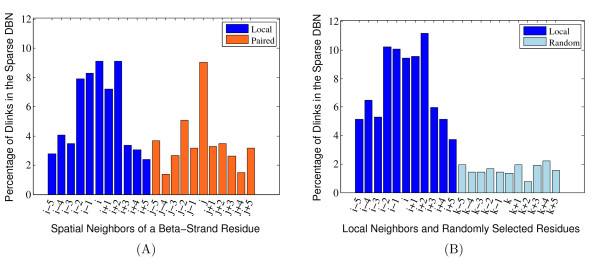
Comparison of the local and non-local correlations in β strands. (A) The figure plots the percentage of dlinks for the local and paired neighbors of a β strand residue at position i. (B) Similar to (A), except that paired neighbors are seleted randomly, rather than according to the true pattern of β strand pairing. The figures suggest a strong correlation between a β strand residue and its local neighbors as well as non-local partners (i.e., those that make hydrogen bridge interaction) as compared to the remaining positions.